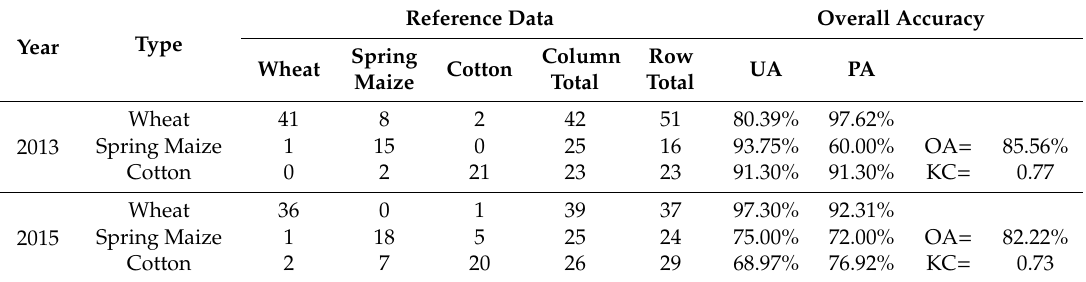
Table 2. Accuracy assessment of land-cover classification results in 2013 and 2015.